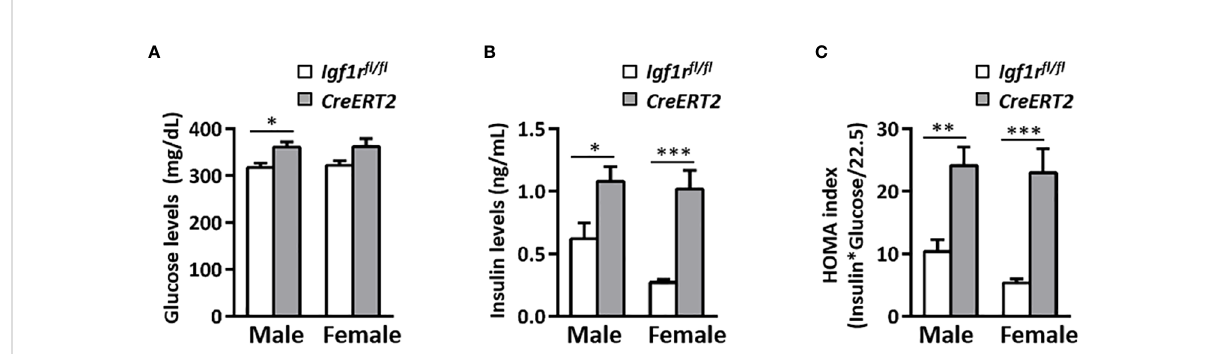
FIGURE 2 Effects of IGF1R de fi ciency on glucose levels and insulin resistance in young mice. (A) Serum glucose levels; (B) serum insulin levels and (C) the insulin resistance index (HOMA) determined in 13 weeks-old mice. Data are expressed as mean ± SEM of at least 7 animals per group (n=7-14